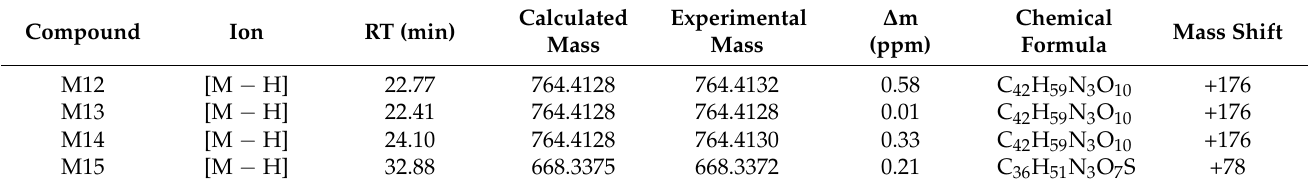
Table 4. Phase II putative metabolites of UniPR500 in liver microsomes and S9